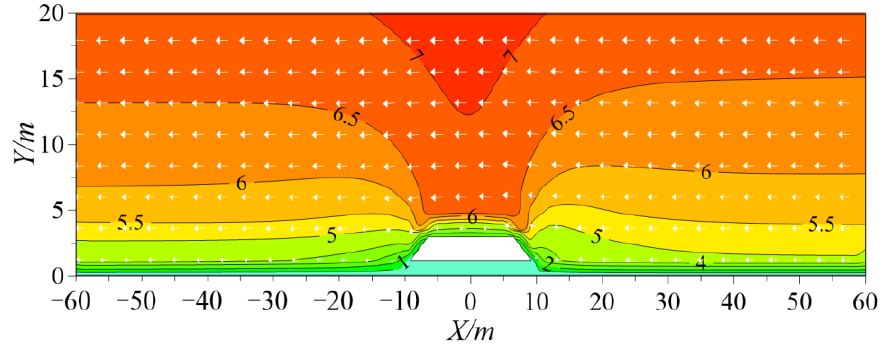
Figure 9. Modeled distribution of the wind field around the NACE in February.